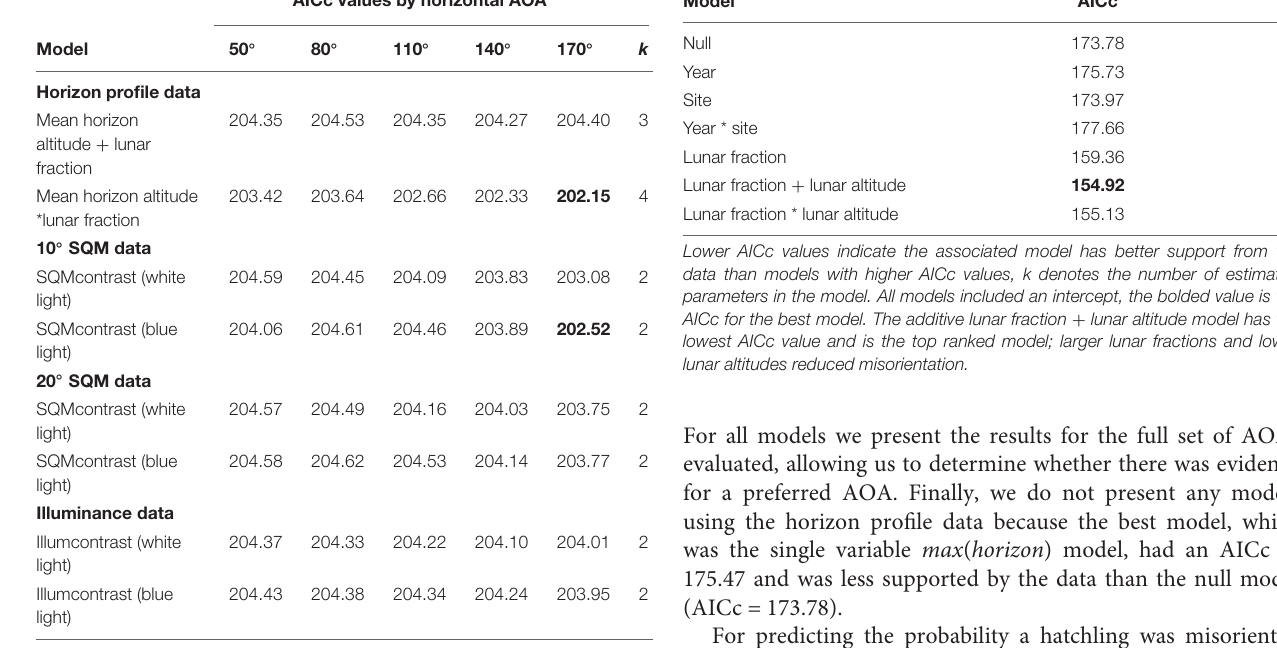
TABLE 4 | Model selection results for nest-at-risk models that involve an angle of acceptance (AOA). AICc values by horizontal AOA